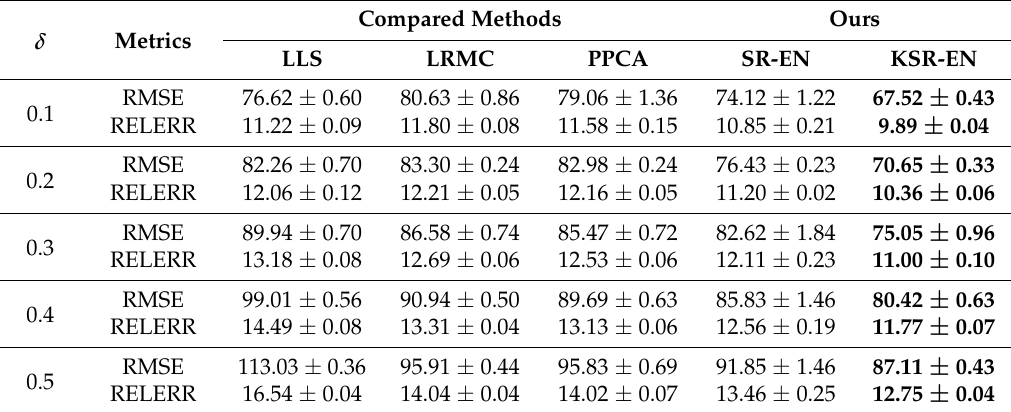
Table 2. Imputation error RMSE and RELERR obtained by different approaches under missing completely at random (MCAR) missing pattern. The best results are highlighted in bold.